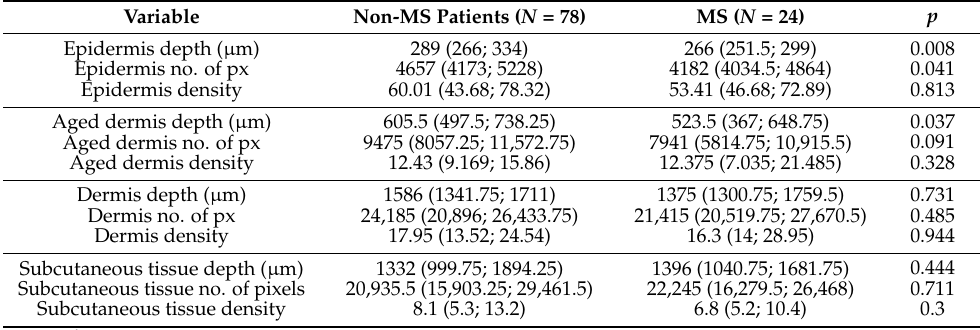
Table 2. Ultrasound assessment of zygomatic skin in MS patients vs. controls.